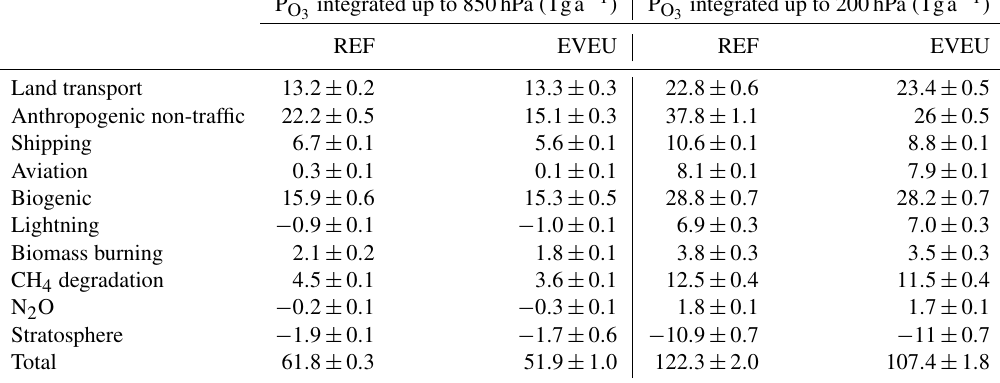
Table 9. Diagnosed net ozone production (P O ) of the 10 considered categories (in Tga − 1 ) as simulated by CM50. The production rates are 3 integrated over the CM50 domain and up to 850 / 200hPa, respectively. The values are averaged for 2008–2010, and the ranges indicate one standard deviation with respect to time based on the annual averages of the individual